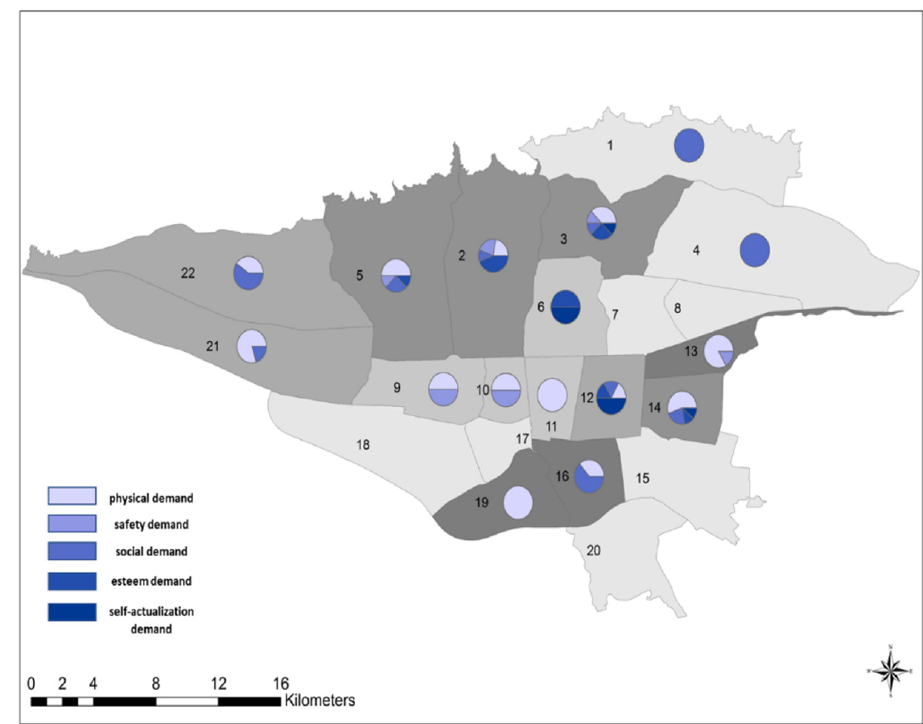
Fig. 4: Smart cities implemented projects in 22 districts of Tehran from the perspective of Maslow’s hierarchy of needs